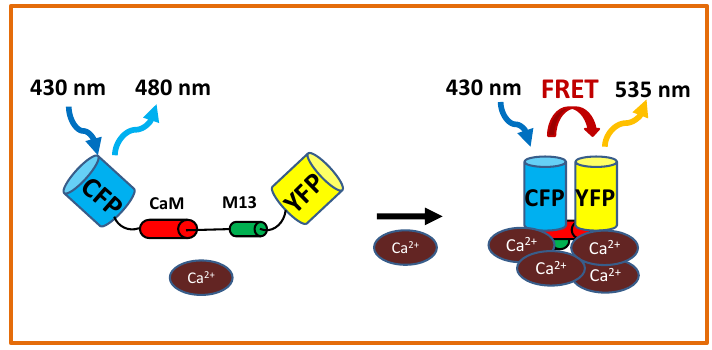
Figure 2. Yellow cameleons are Ca 2 + sensors based on Förster Resonance Energy Transfer (FRET). Yellow and Cyan Fluorescent Proteins (YFP and CFP) are mutated forms of the green fluorescent protein that absorb and emit light at matching wavelengths, such that the excitation wavelength of YFP is the emission wavelength of CFP. The sensor is constructed by attaching CFP and YFP by the Ca 2 + -binding protein Calmodulin (CaM) and a calmodulin binding peptide (M13) [24]. When Ca 2 + concentration increases, CaM undergoes a conformational change as it binds to Ca 2 + , which brings YFP and CFP closer together and results in enhanced FRET. At the level of a single yellow cameleon construct, a rise in Ca 2 + concentration is indicated by a drop in the CFP intensity at the same time that the YFP intensity increases, leading to an increase of the YFP/CFP